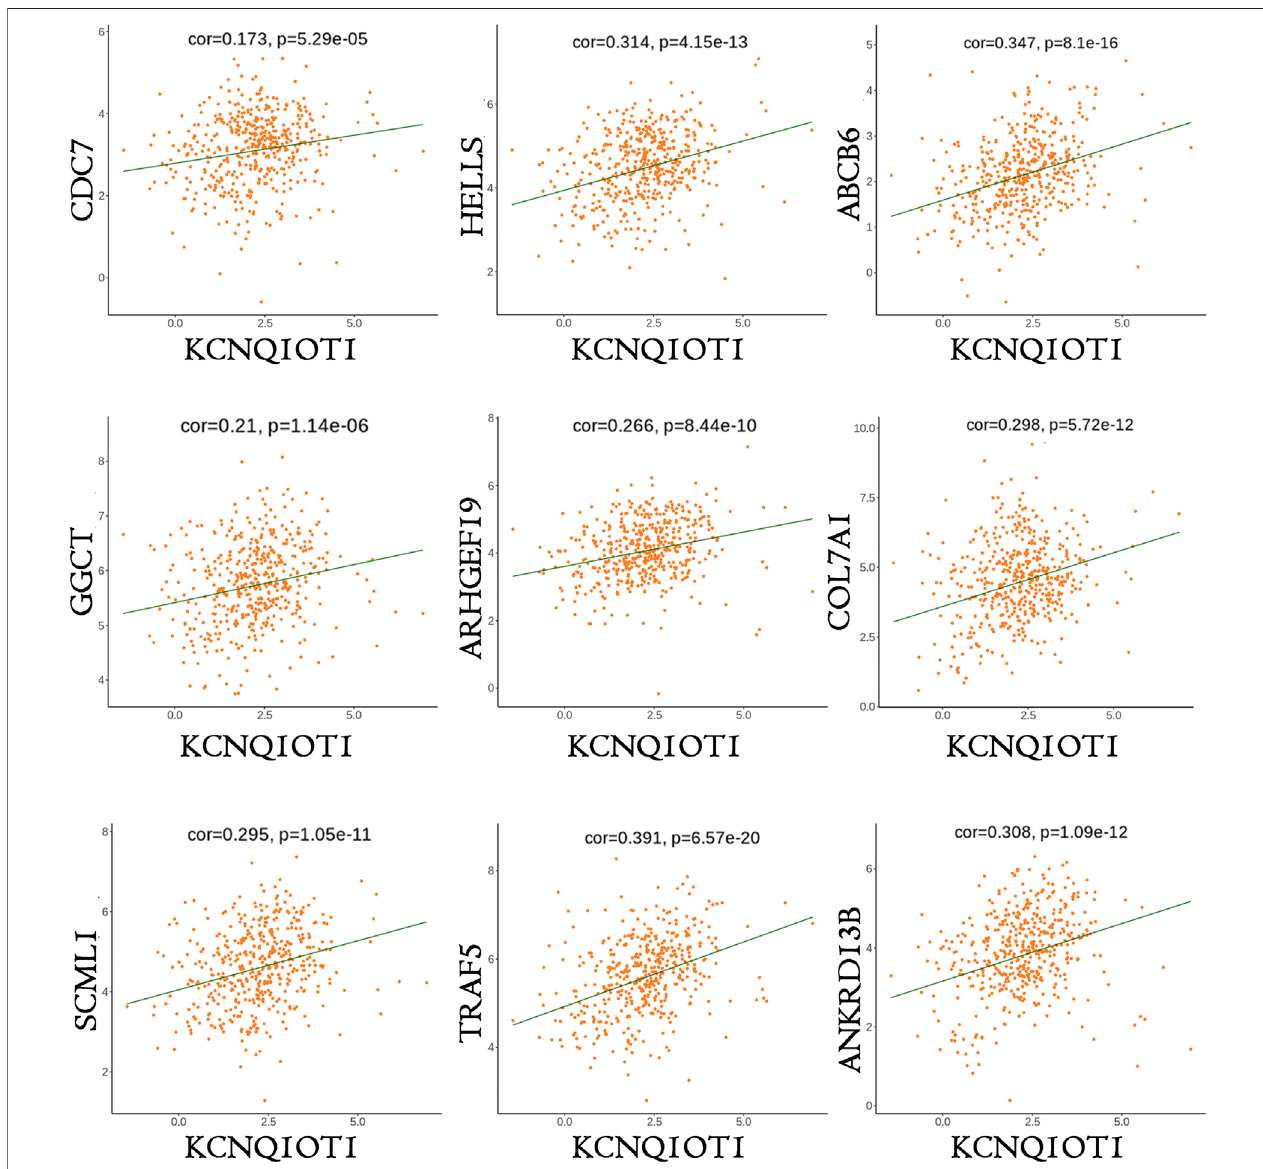
FIGURE 6 | Co-expressions of mRNAs and KCNQ1OT1 in KCNQ1OT1 ceRNA network.